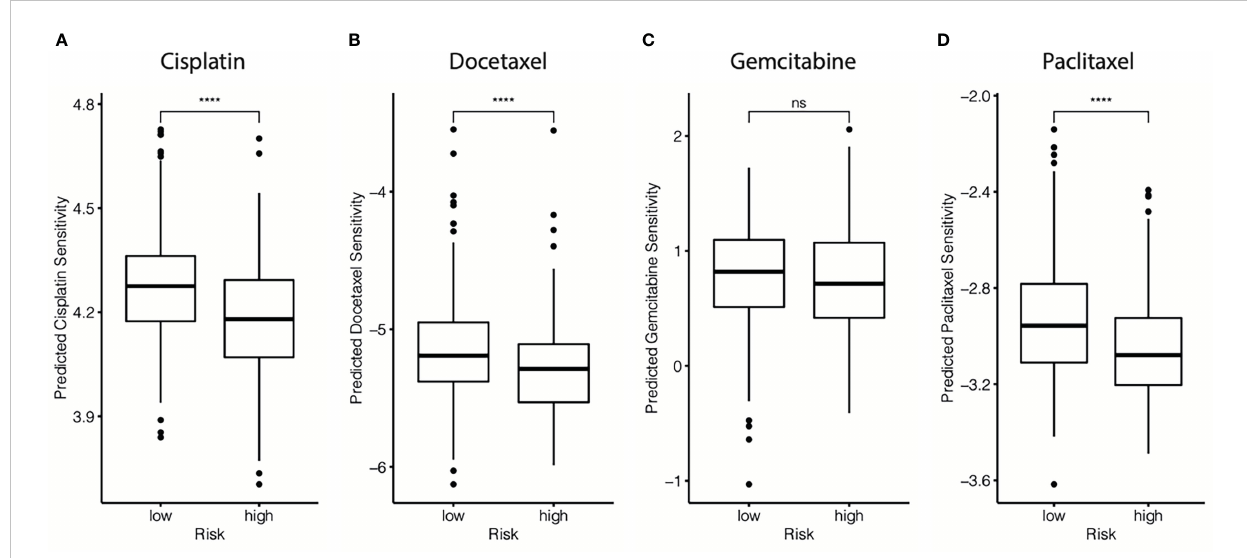
FIGURE 12 Drug resistance predictions in different cr-TILCD8TSig subgroups. Treatment response of cisplatin (A) , doxorubicin (B) , gemcitabine (C) , and paclitaxel (D) were estimated and compared in the GSE25066 cohort. Values were considered statistically signi fi cant at p<0.05 (****,